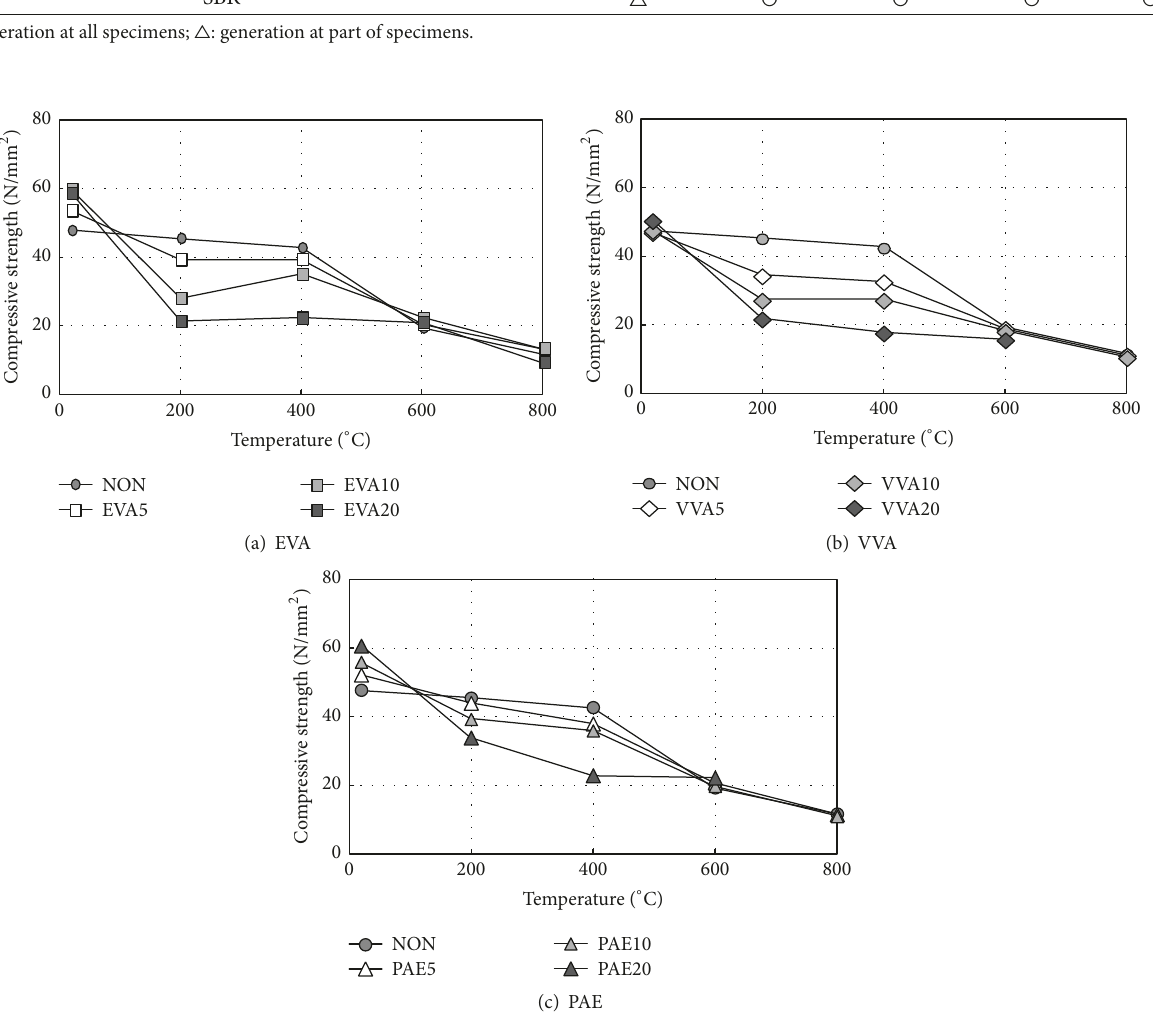
Figure 13: Compressive strength of PCM with various polymers at high